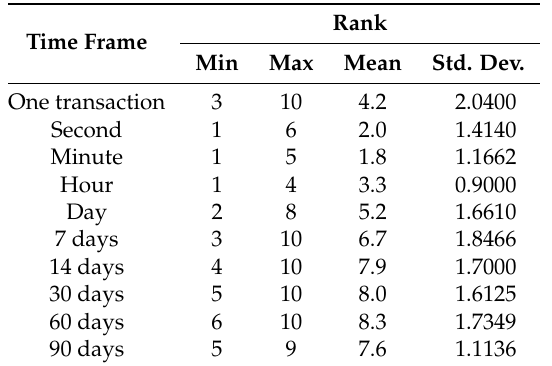
Table 1. Ranks for different time frames of feature extraction